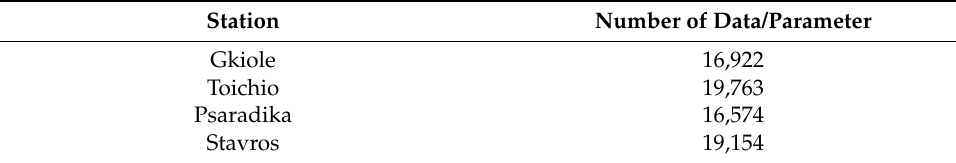
Table 1. Number of